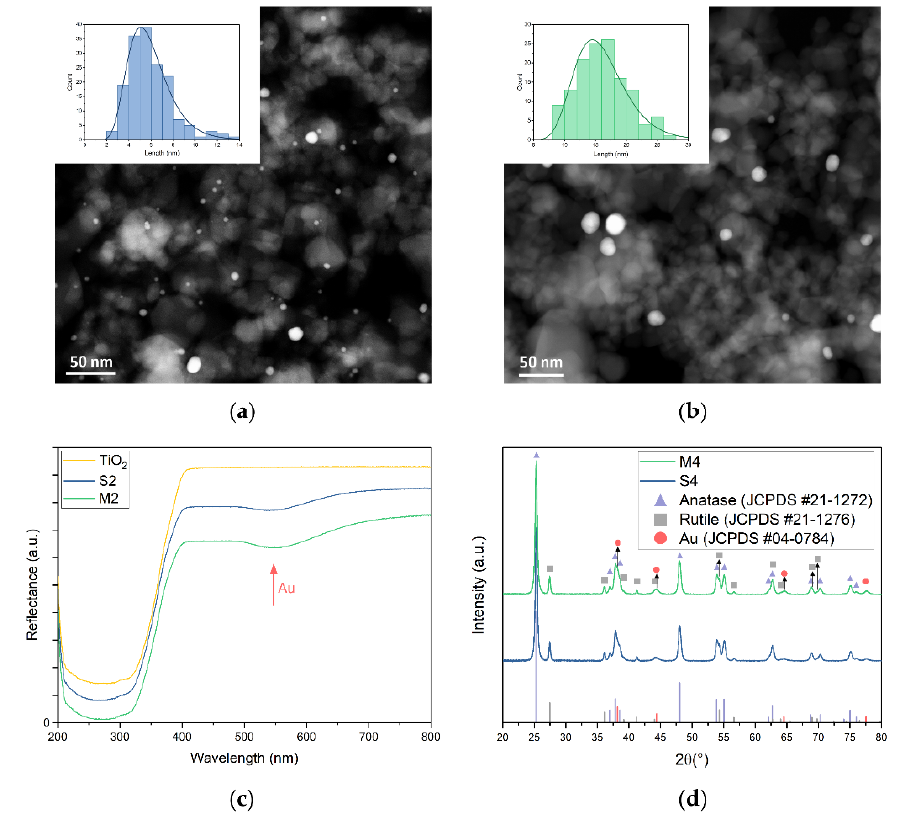
Figure 1. ( a ) HAADF-STEM image of S2 catalyst with Au nanoparticle size histogram, consisting of a count (bars) and lognormal plot (curve) of particle sizes; ( b ) HAADF-STEM image of M2 catalyst with Au nanoparticle size histogram, consisting of a count (bars) and lognormal plot (curve) of particle sizes; ( c ) diffuse reflectance UV-vis spectra of bare P25 TiO 2 , S2 and M2 catalysts. The plasmonic Au absorption band is highlighted; ( d ) X-ray diffractograms of S4 and M4 catalysts. Anatase, rutile and metallic Au are identified using PDF database